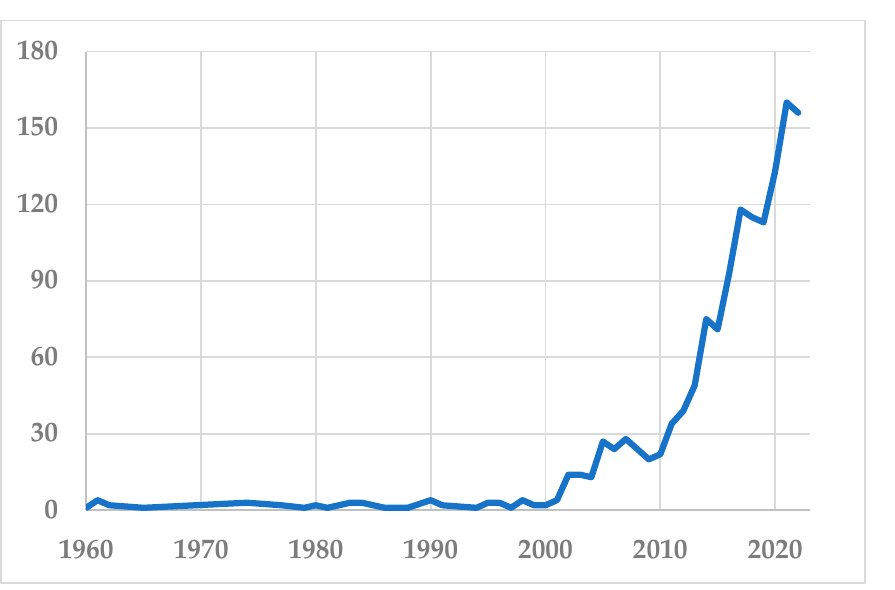
Figure 1. Scientific publications 1960–2022 on food toxicology. Source: PubMed, National Library of Medicine, Bethesda, MD, USA. Search term: “food toxicology”, search conducted 16 December 2022.